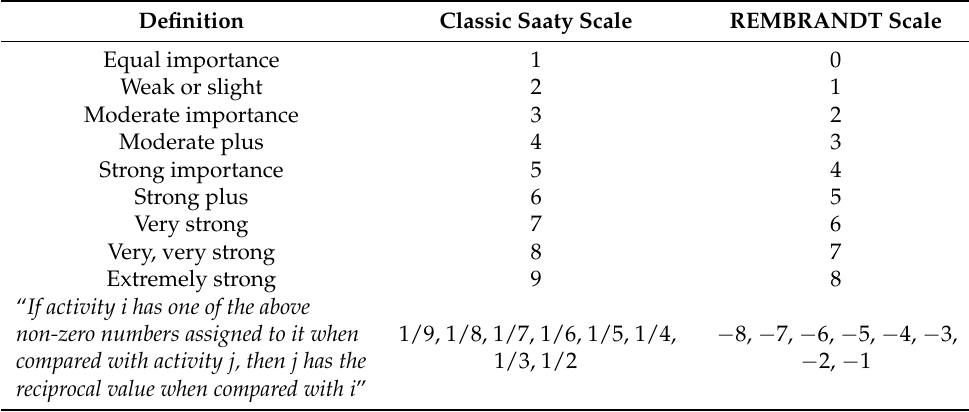
Table 2. The classic Saaty scale and the scale used in the REMBRANDT